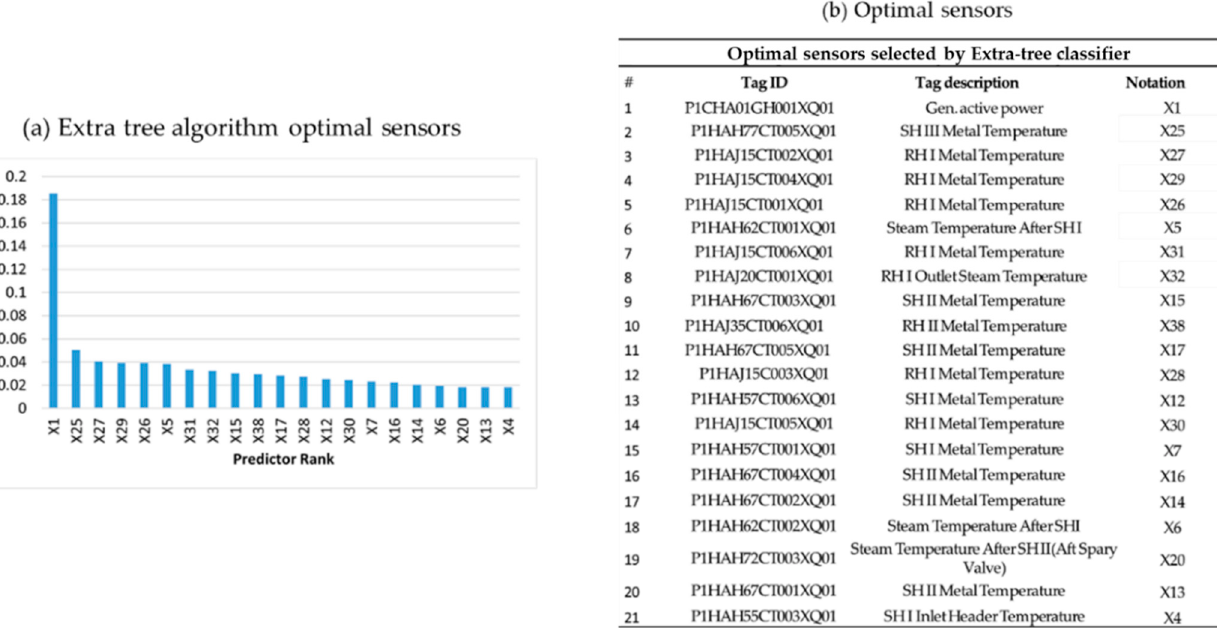
Figure 10. ( a ) Extra-tree classifier selected sensors; ( b ) optimal sensors selected by the extra-tree classifier.